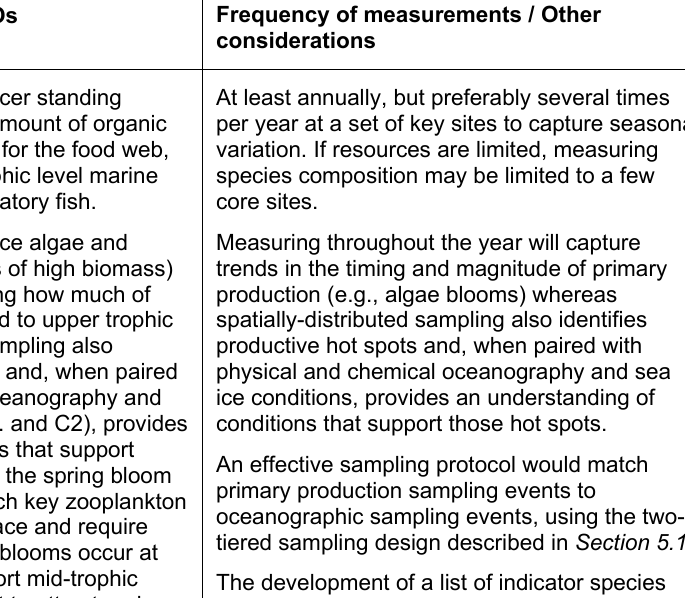
Table C6.2 Key measurement parameters for monitoring ice-associated, under-ice, and open-water primary producers (Section 6.2).